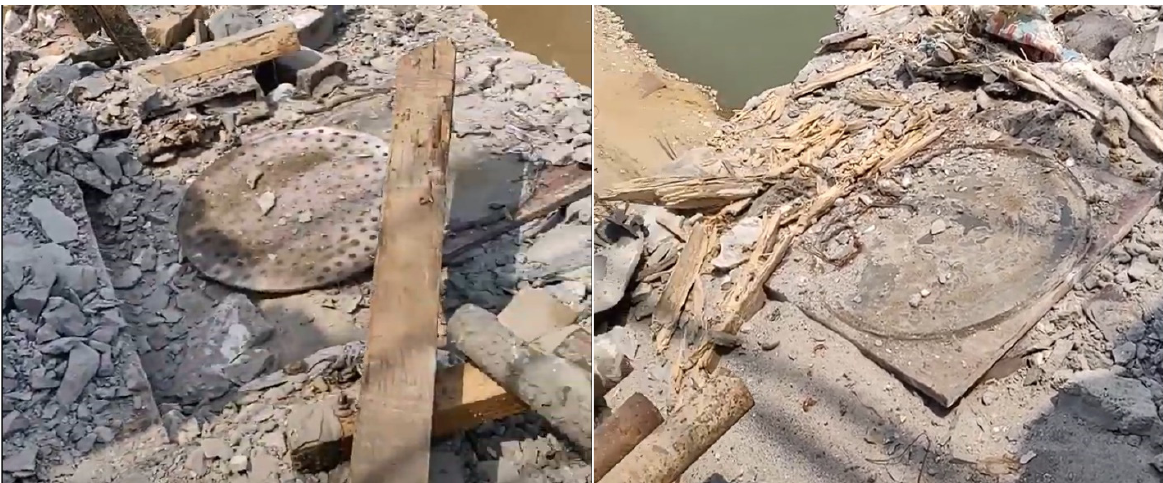
Figure 15. Damaged bearing above Pier-1, span-2 side (downstream and upstream side).